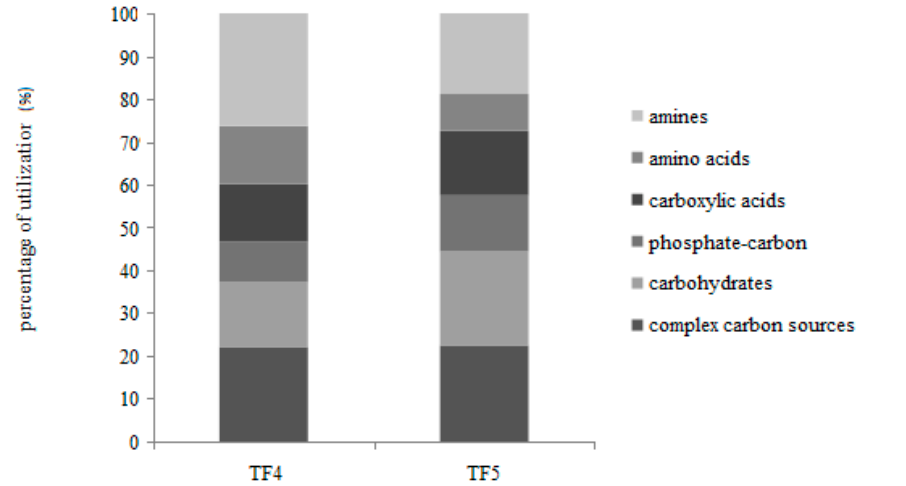
Figure 3. Individual carbon source oxidation—as a percentage of the total absorbance—in TF4 and TF5 brines.